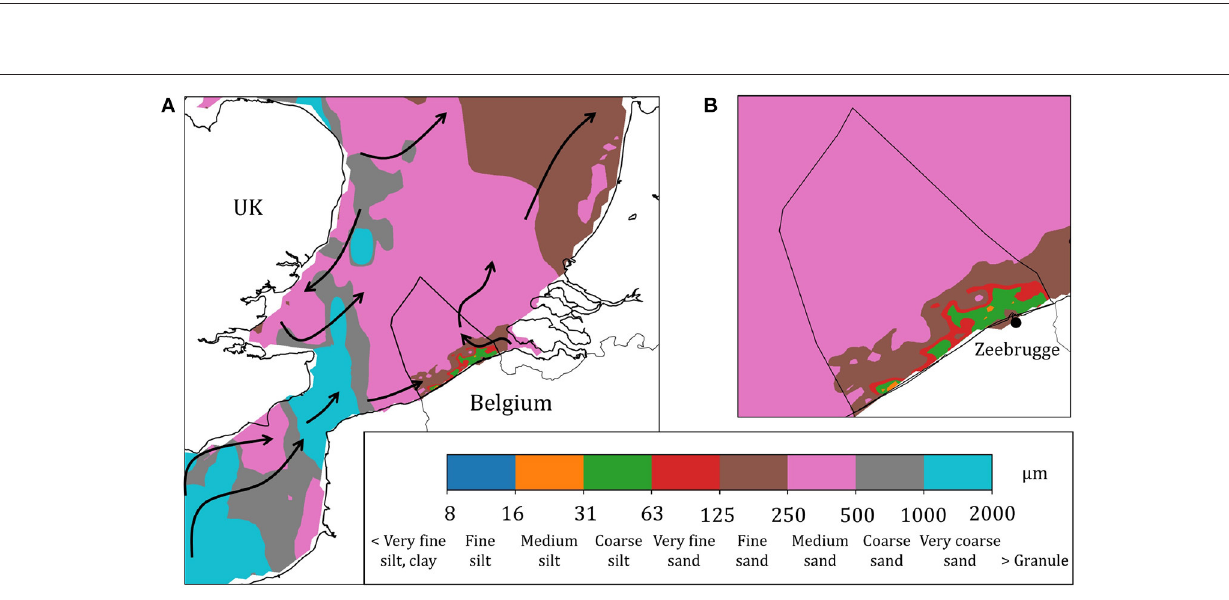
Frontiers in Marine Science |